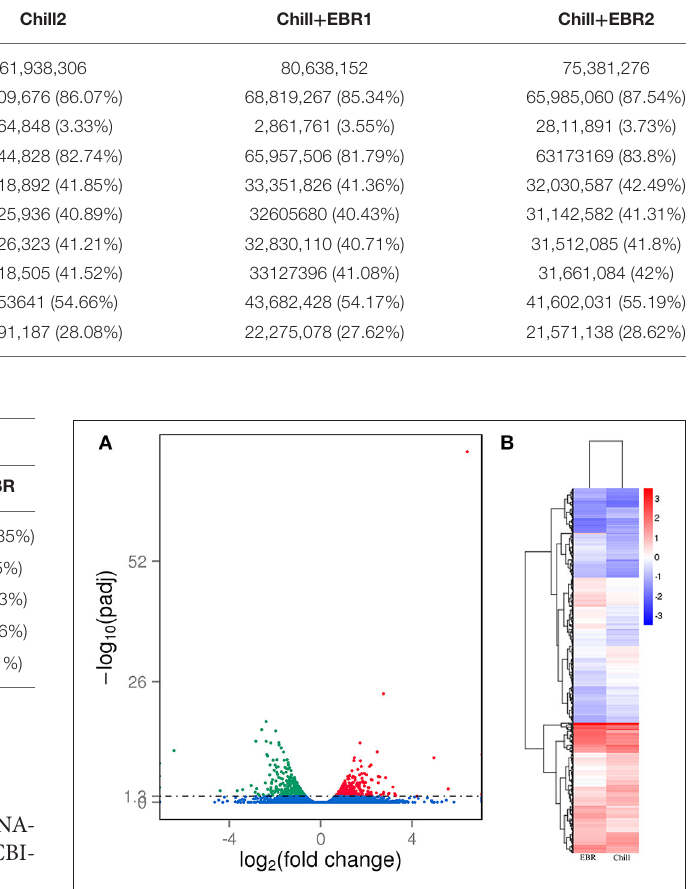
FIGURE 1 | Transcriptome analysis of differentially expressed genes in Chill and Chill + EBR treatment of pepper leaves. (A) Volcano plot showed the DEGs between two different libraries. The q < 0.05 was used as thresholds to determine the significance of DEGs. Red dots represent up-regulated genes, green dots show down-regulated genes, and blue dots indicate transcripts that did not change significantly in the Chill + EBR library compared Chill. (B) Hierarchical clustering of all the DEGs based on log 10 RPKM values. The color (from blue to red) represents gene expression intensity from low to high. Chill and Chill + EBR represent two treatments under alone chilling stress and chilling stress with 0.1 µ M